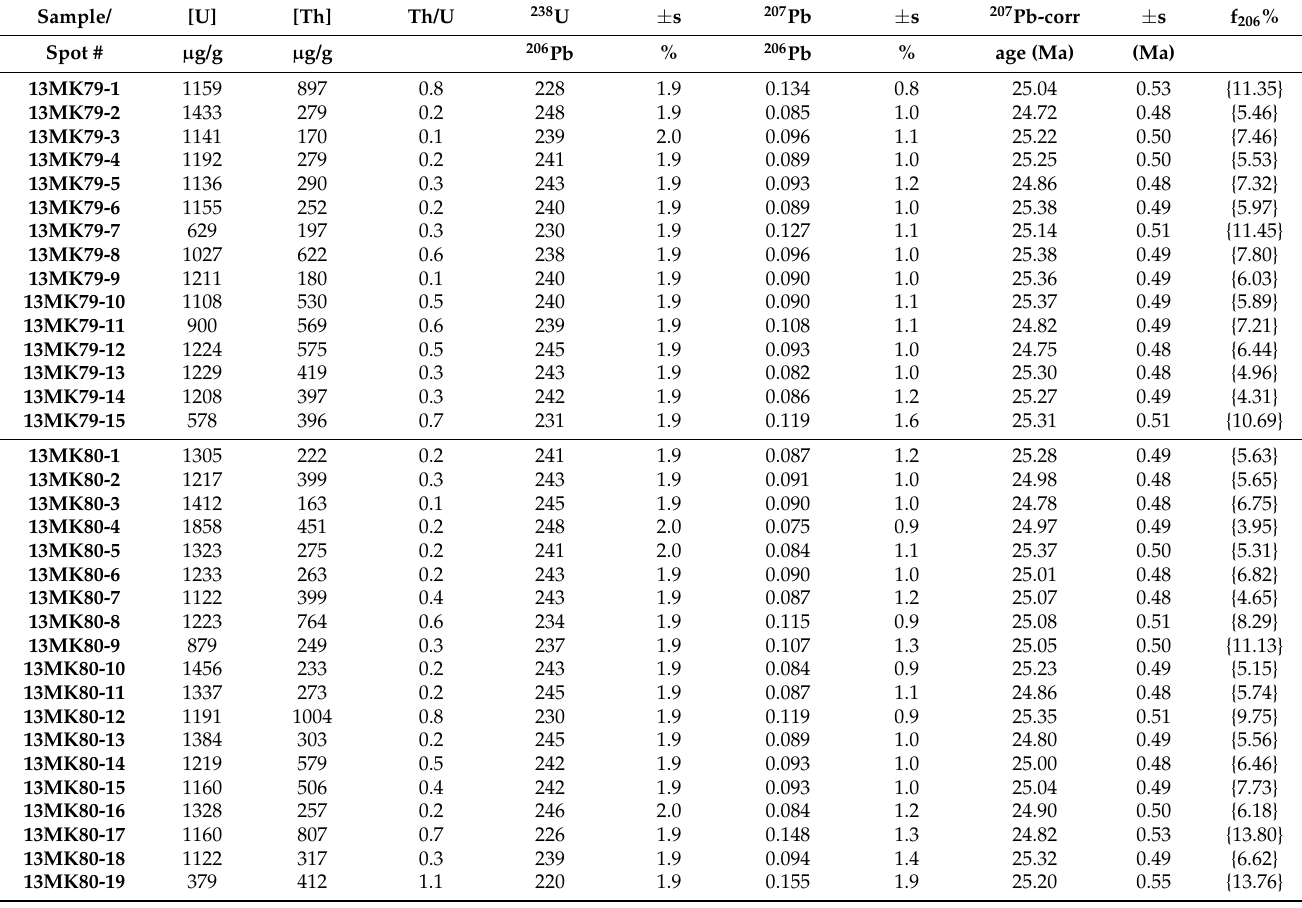
Table 1. U–Th–Pb analytical results of titanite in ruby-bearing marbles from the Mogok Stone Tract.